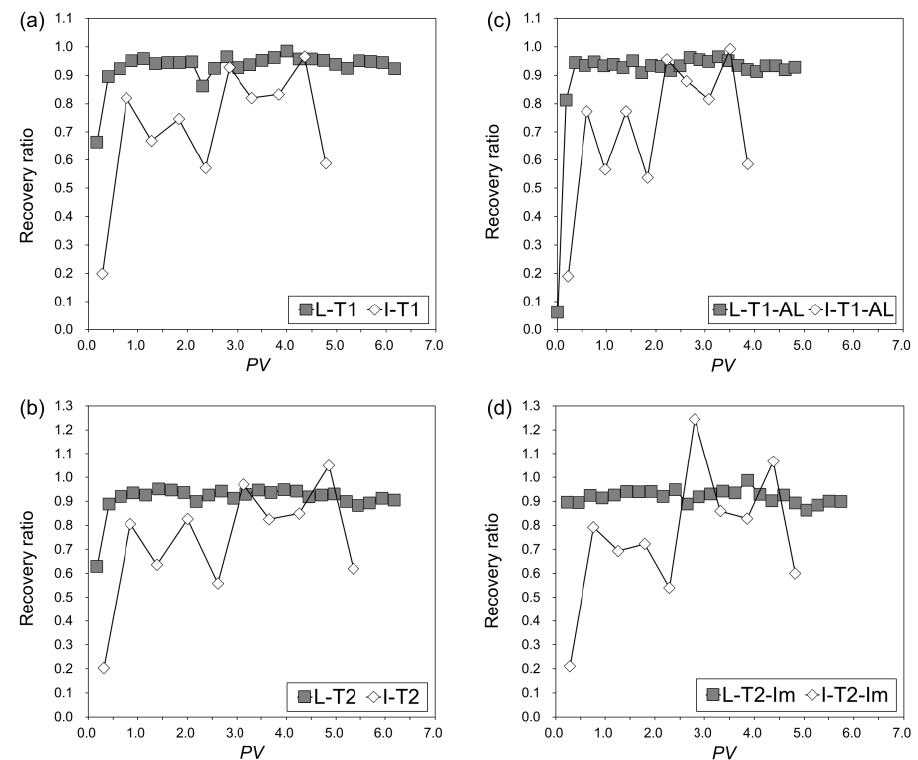
Figure 8. Changes in recovery ratio with PV ; ( a ) comparison between L-T1 and I-T1, ( b ) comparison between L-T2 and I-T2, ( c ) comparison between L-T1-AL and I-T1-AL and ( d ) comparison between L-T2-Im and I-T2-Im.